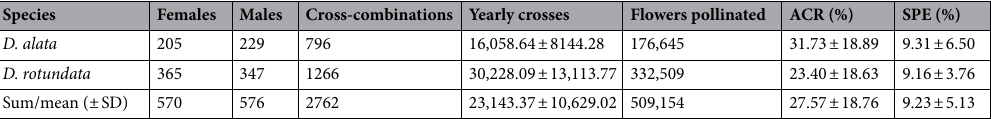
Table 1. Intraspecific cross-compatibility indices within D. alata and D. rotundata genotypes. ACR = average crossability rate, SPE = seed production efficiency. SD = standard deviation. Yearly crosses, ACR and SPE are presented by means ± standard